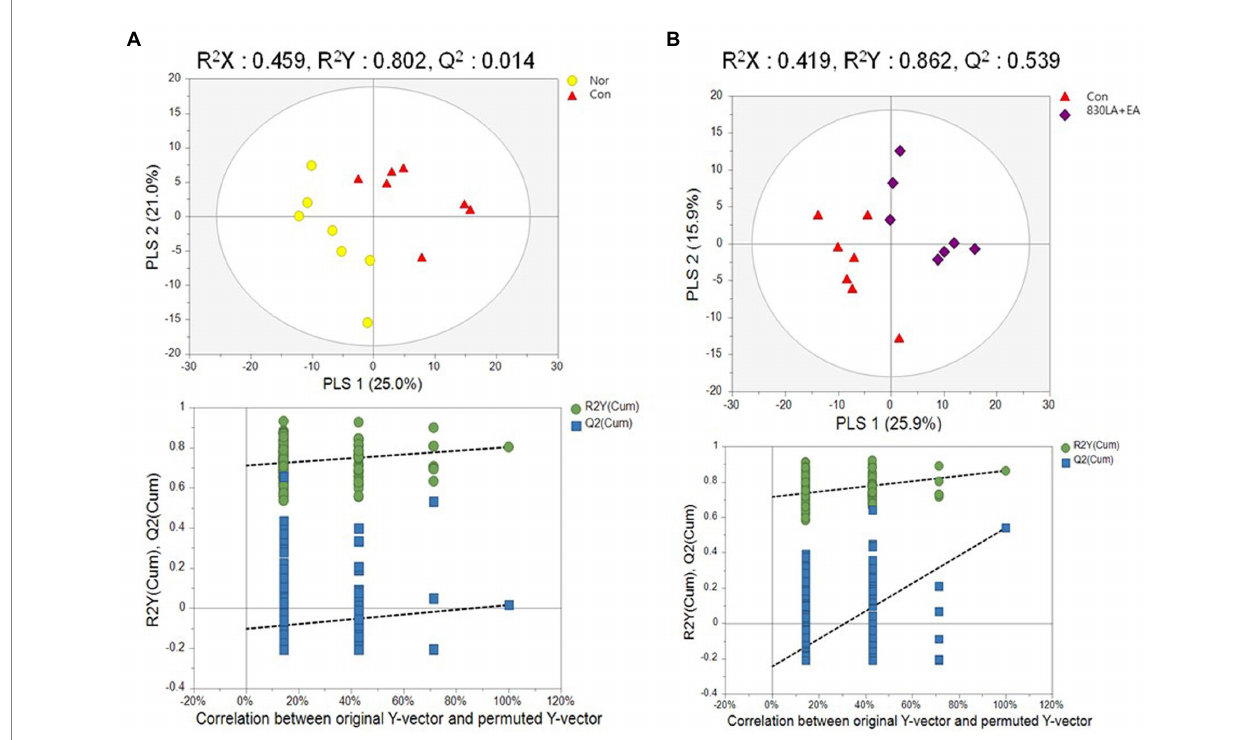
FIGURE 4 A PLS-DA score plot in rats with paclitaxel-induced allodynia according to type of acupuncture treatment. The Nor and the Con group show a tendency to separate, but the permutation test revealed no significant difference ( Q 2 = 0.0145, A ). The PLS-DA result showed a pattern of separation between the Con group and the 830LA + EA group, and the permutation test showed a significant difference ( Q 2 = 0.5399, B ). EA, electro acupuncture; LA, laser acupuncture; Nor, normal; Con,